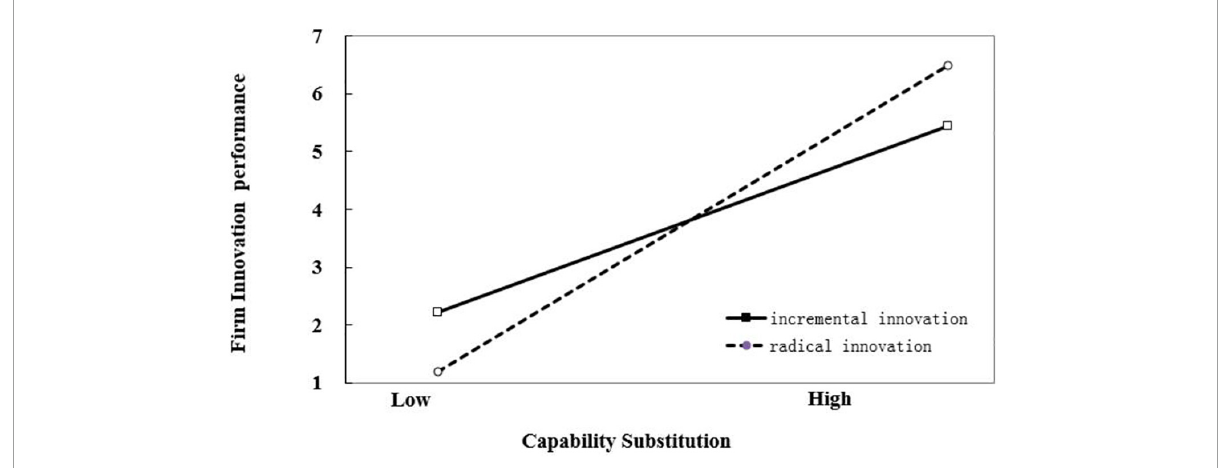
FIGURE4 Moderating effect of innovation magnitude on the relationship between capability substitution and firm innovation performance in the late stage of